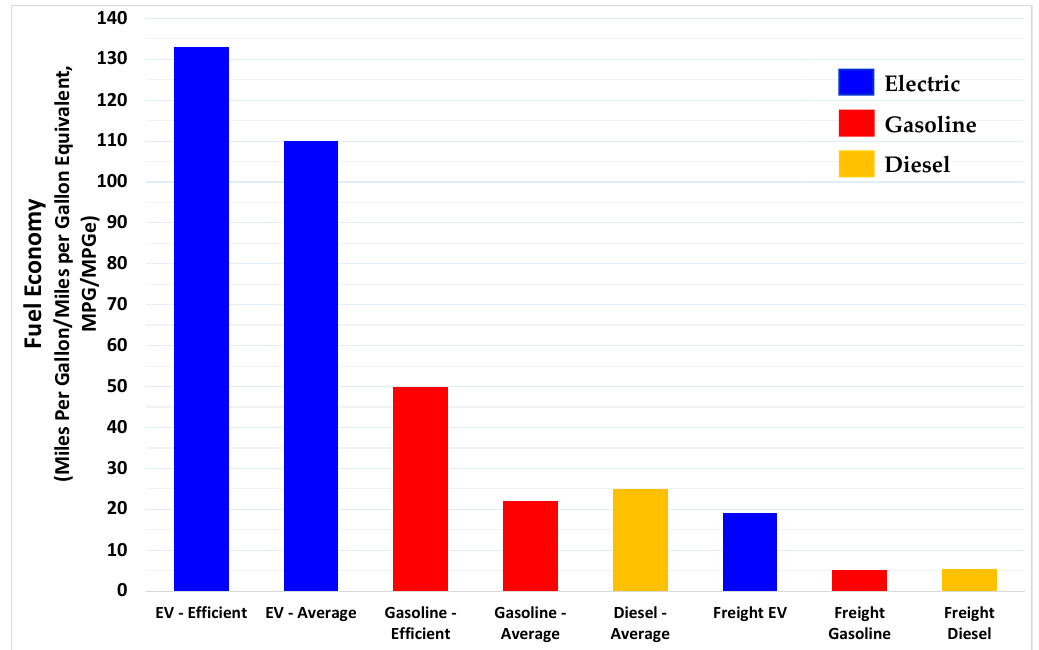
Figure 2. Average fuel economy for passenger and freight vehicles included in this analysis by vehicle type and by fuel (in Miles Per Gallon Gasoline Equivalent (MPGe) and MPG). For passenger vehicles, both average and efficient plug-in Electric Vehicles (EVs) ( blue bars ) were compared with average and efficient gasoline ( red bars ), as well as average diesel vehicles ( yellow bars ). Average freight EVs, gasoline and diesel were also compared.